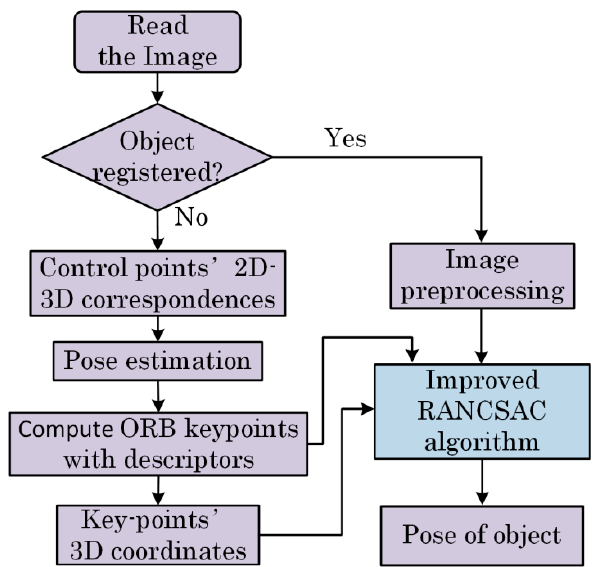
Figure 8. The flow chart of model registration and pose estimation. Model registration is the first step before pose estimation.